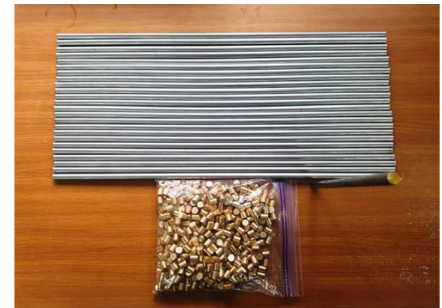
Figure 22: Simulated rod-cuts (length: 500mm).